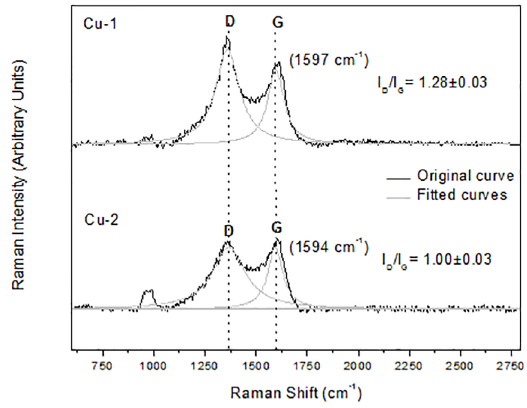
Figure 1. Raman spectra of the samples Cu-1 and Cu-2